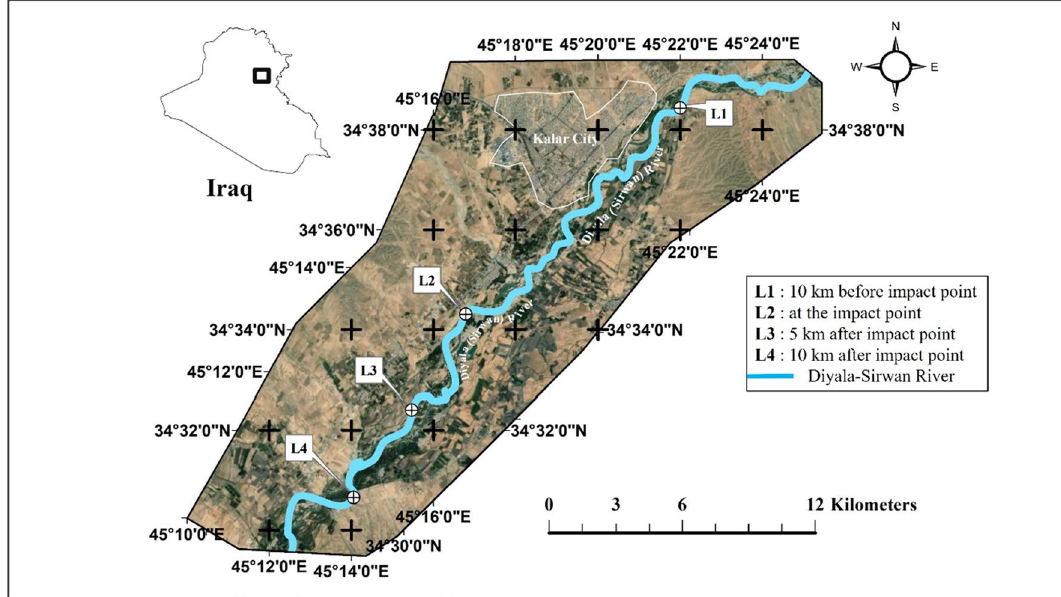
Fig. 1 The study area with showing sampling